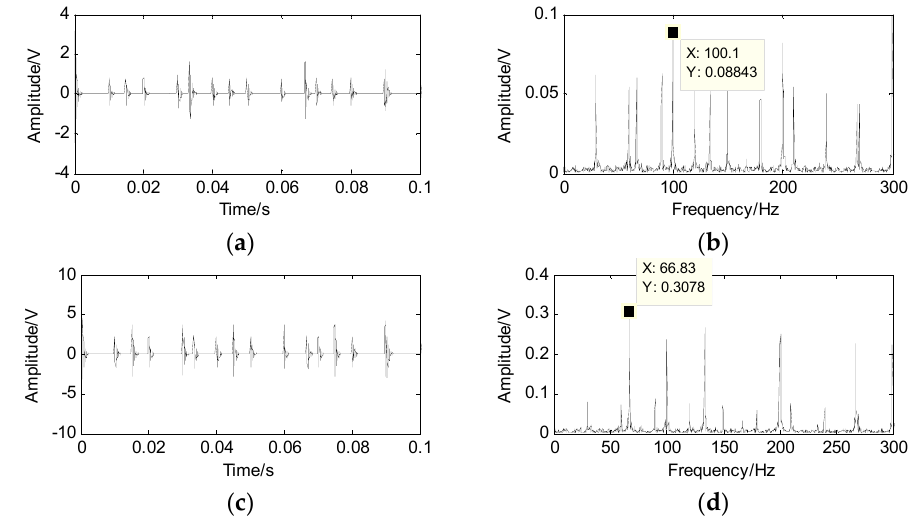
Figure 3. Mixed of simulated signals and their spectra. ( a ) the first mixed signal x 1 ; ( b ) the spectrum of x 1 ; ( c ) the second mixed signal x 2 ; ( d ) the spectrum of x 2 .